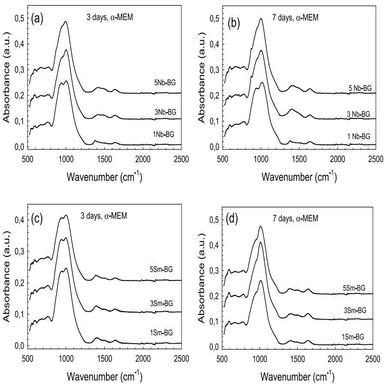
FTIR spectra of the (a),(b) Nb5+; (c),(d) Sm3+-containing bioactive glass powders treated in α-MEM for 3 days (left column) and 7 days (right column).